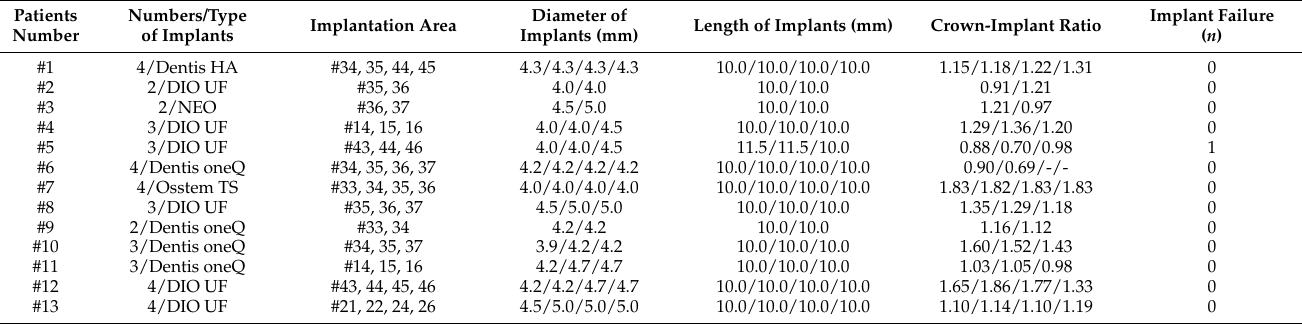
Table 2. Implant